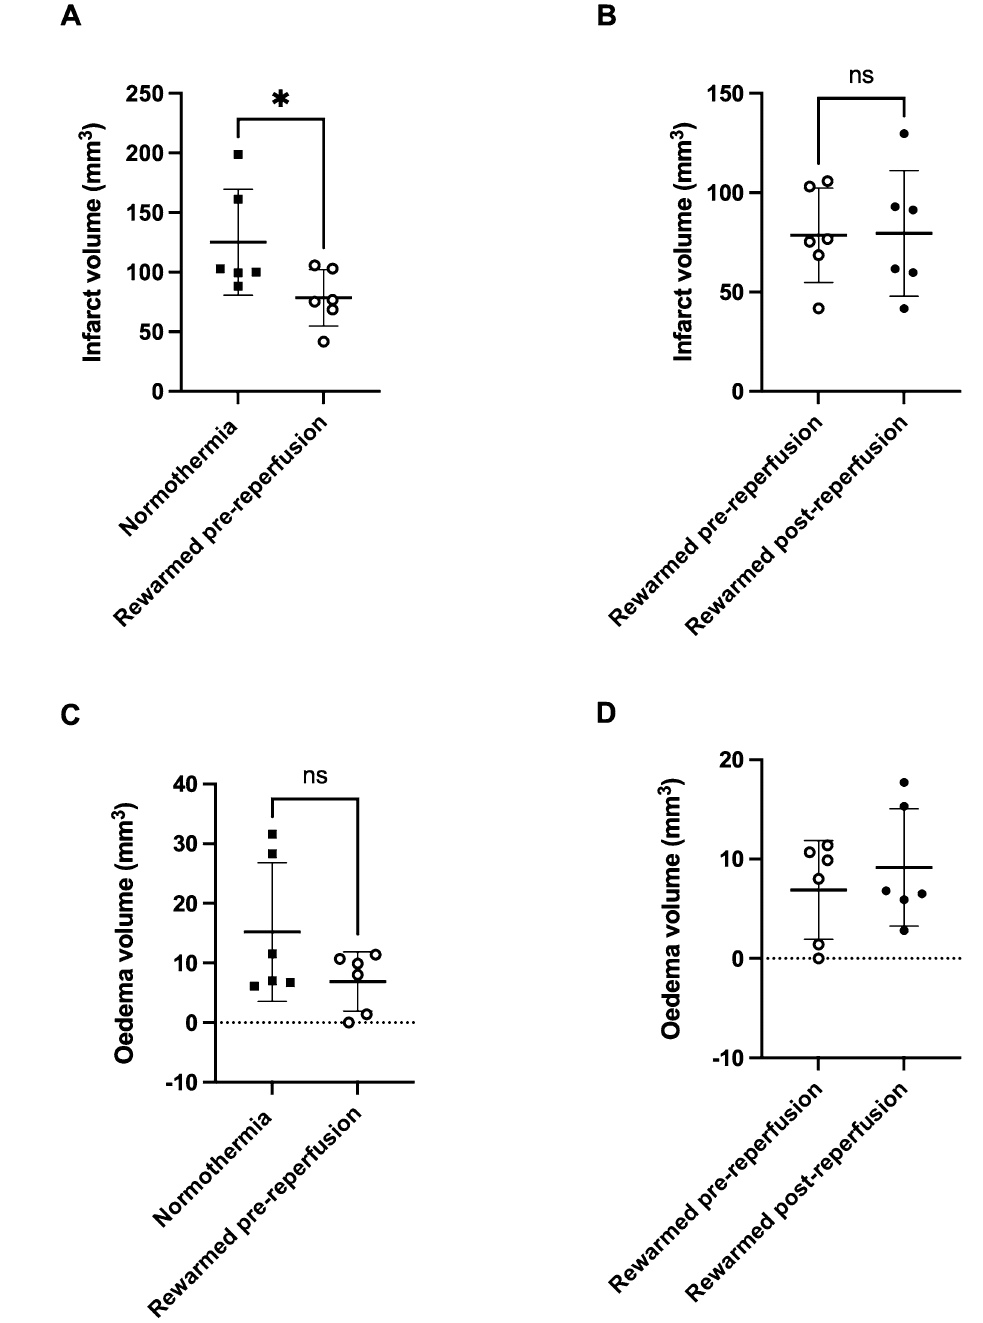
Figure 3. Infarct and oedema volume from H&E staining. ( A , C ) Rewarmed pre-reperfusion and normothermia, and ( B , D ) rewarmed pre-reperfusion and rewarmed post-reperfusion groups. * p < 0.05. NS not